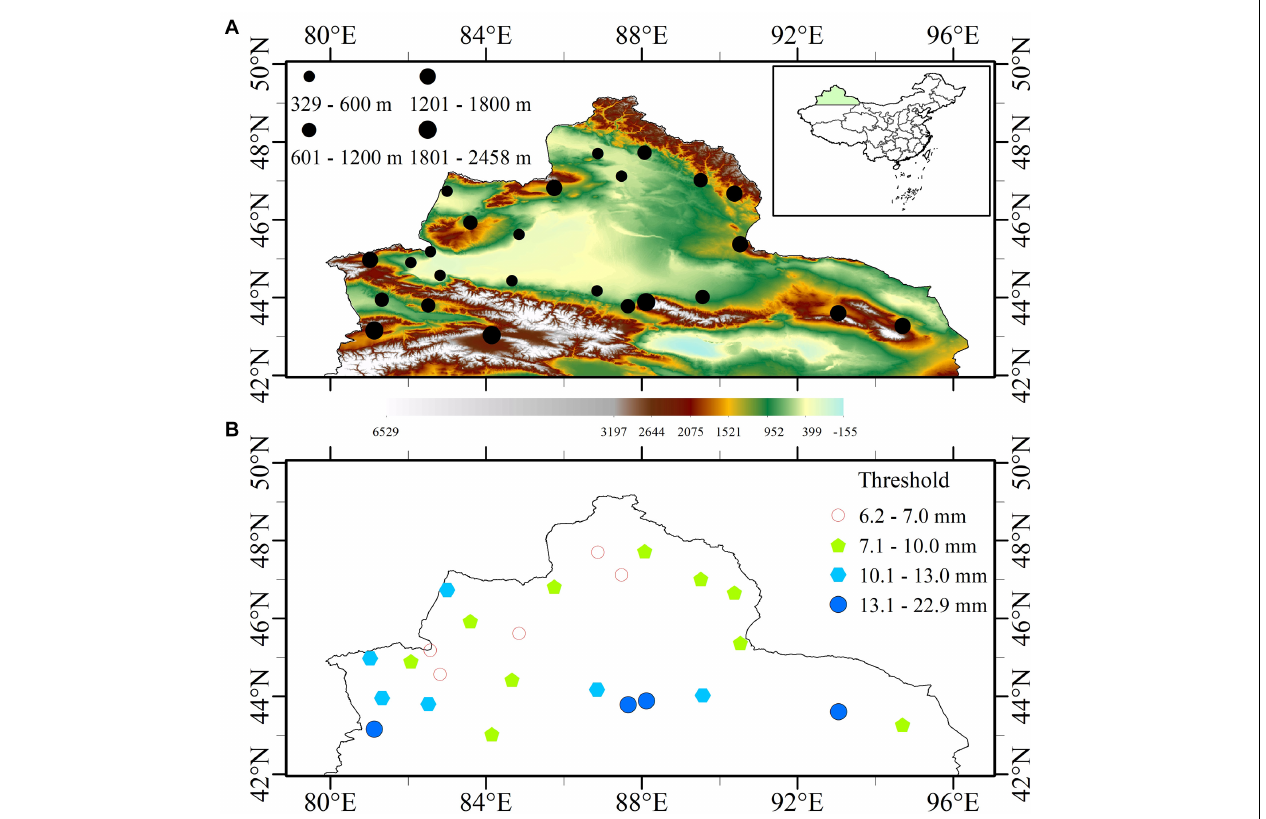
FIGURE 1 | (A) Topography for Northern Xinjiang and location of the 25 stations. (B) The 95th percentile thresholds used to define extreme precipitation events.